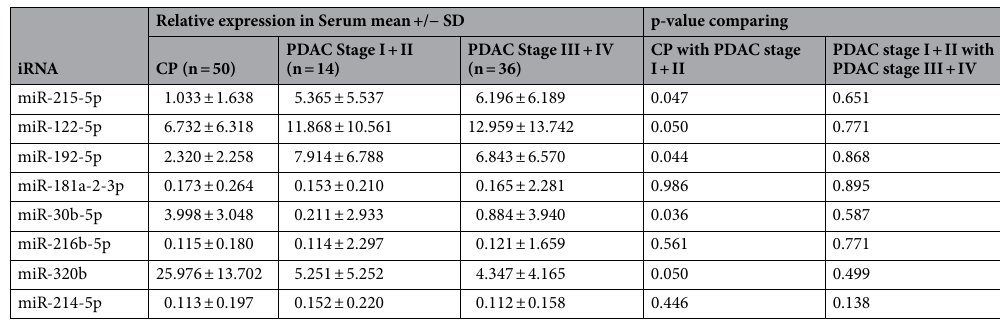
Table 3. Comparison of relative expression of miRNAs in serum samples of CP and different stages of PDAC.